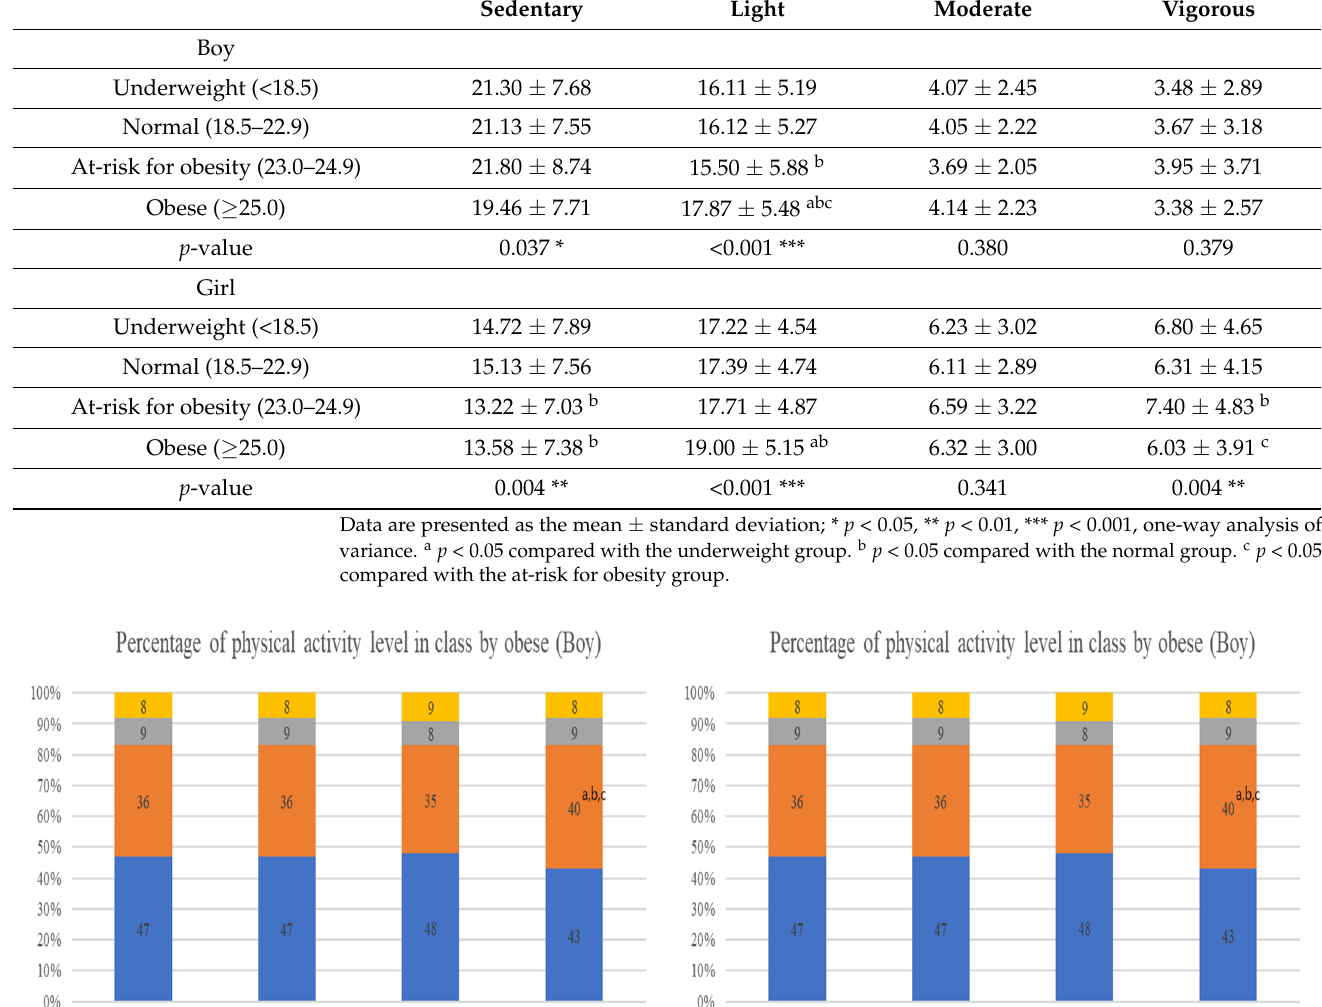
Table 2. Time of physical activity in class by obesity group. Sedentary Light Moderate Vigorous